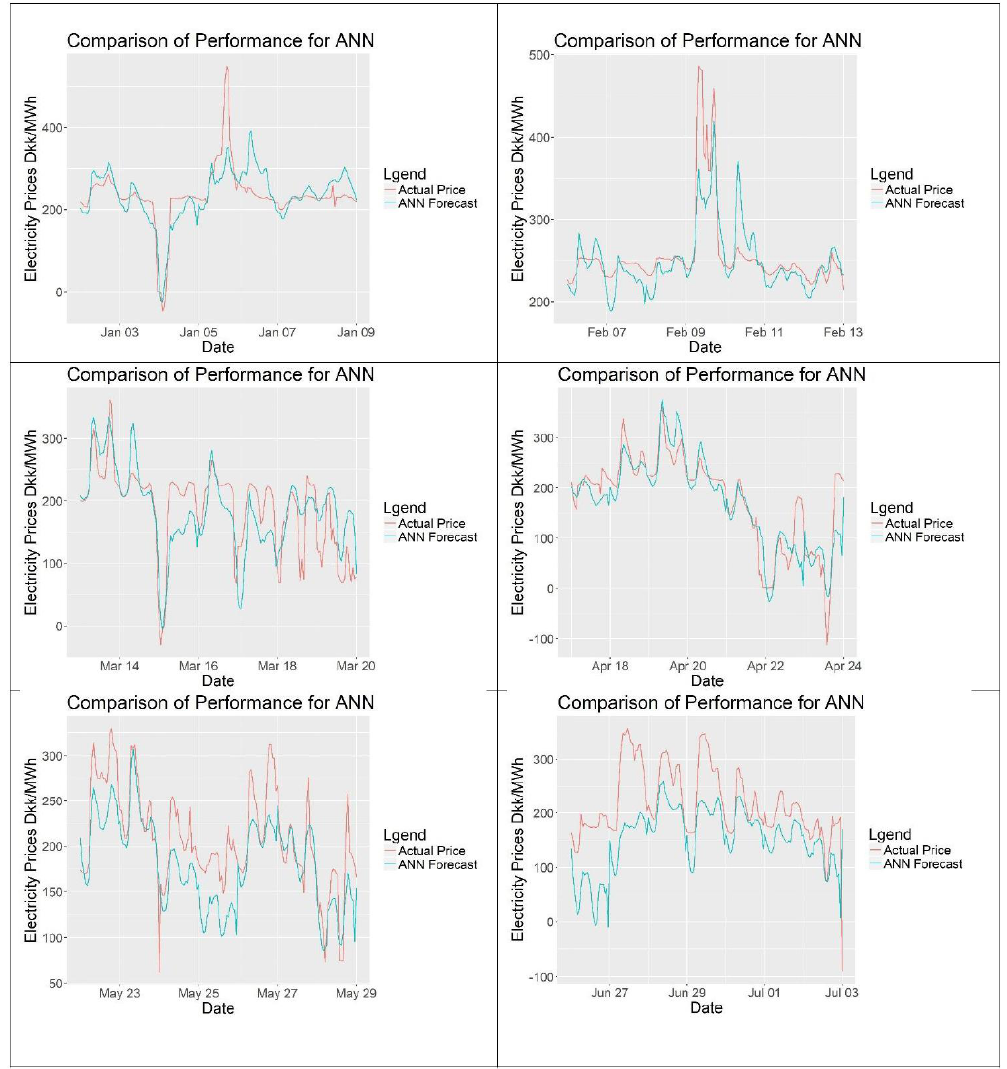
Figure 21. Six different weekly periods for ANN.